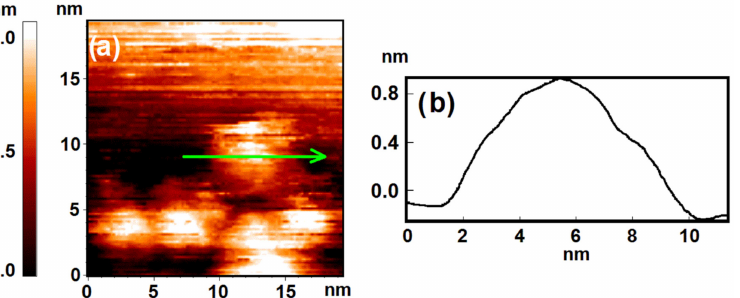
Figure 1. The sample after calcination under UHV conditions. Results of the STM measurement: ( a ) topography image of HOPG surface with deposited clusters of Ni nanoparticles; ( b ) profile of the surface along the cut line shown in ( a ).